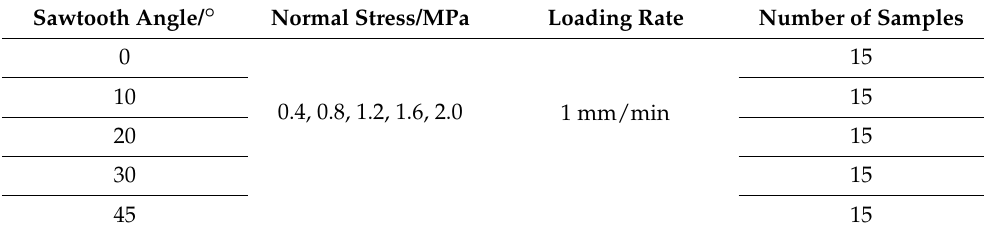
Table 1. Test scheme.